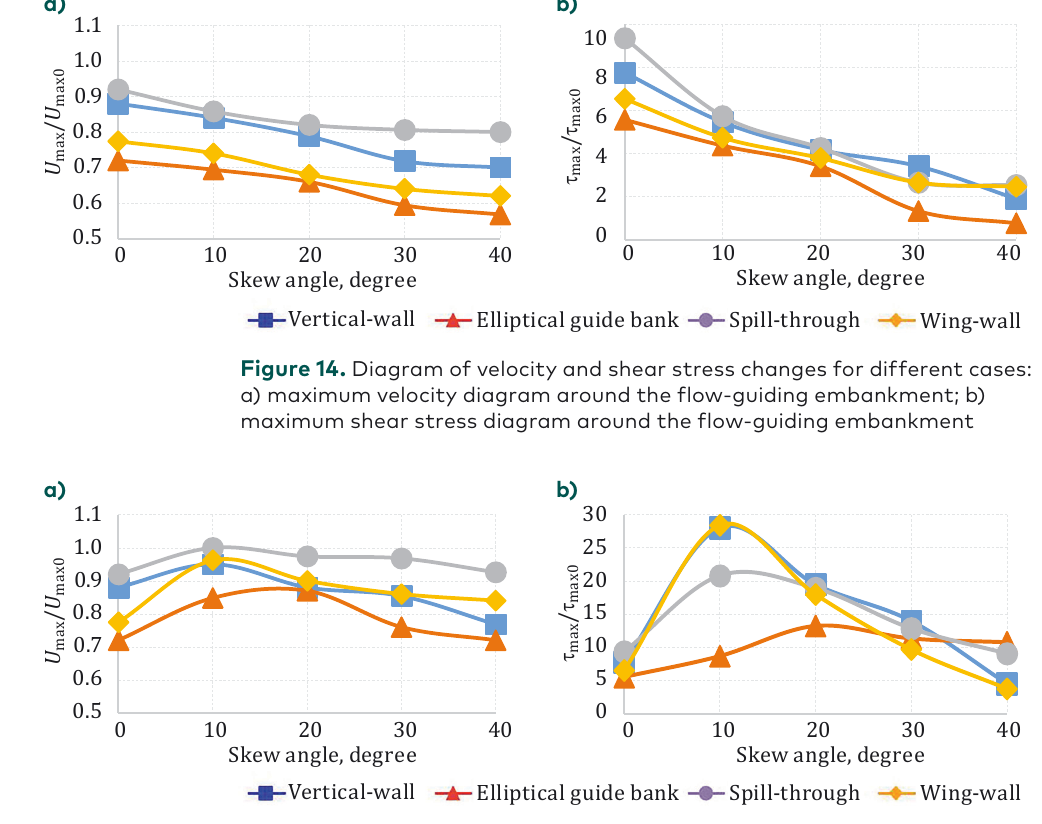
Figure 15. Diagram of velocity and shear stress changes for different cases: a) maximum velocity diagram around the flow-splitting embankment;